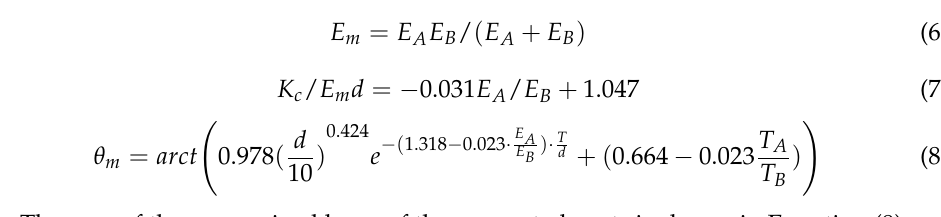
In the formula, E m denotes the equivalent modulus of elasticity of the upper and lower In the formula, E denotes the equivalent modulus of elasticity of the upper and m connected member materials [21]. lower connected member materials [21].